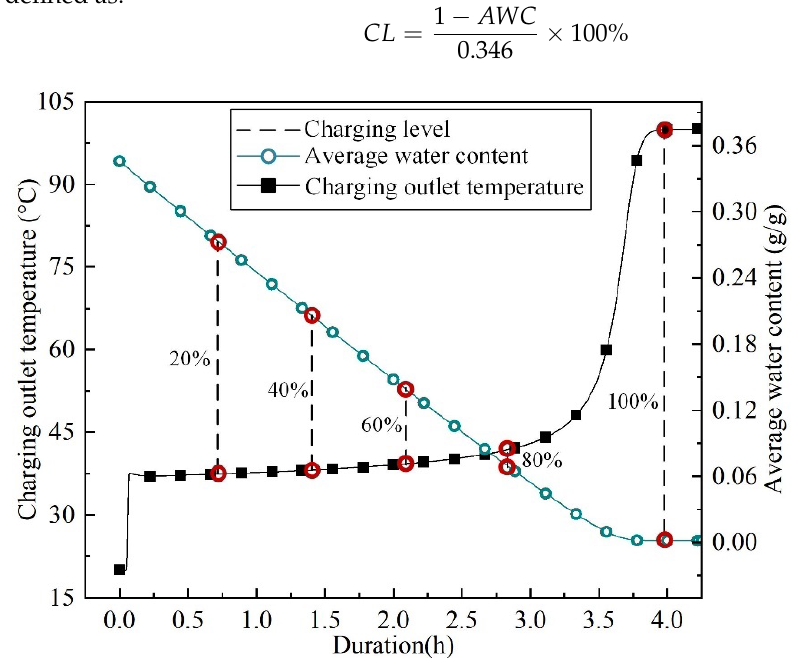
Figure 6. The change in the temperature at the reactor outlet, the average water content of materials and charging level with time.